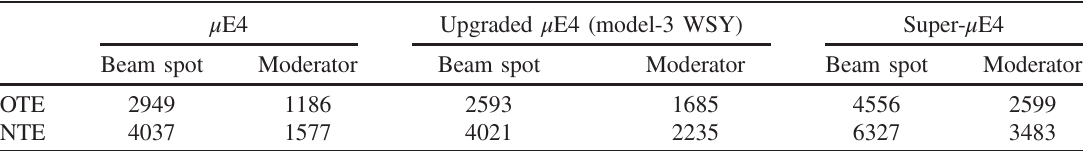
TABLE II. Comparison of the simulated beam intensity of the μ E 4 beam at the moderator position for different target and beamline